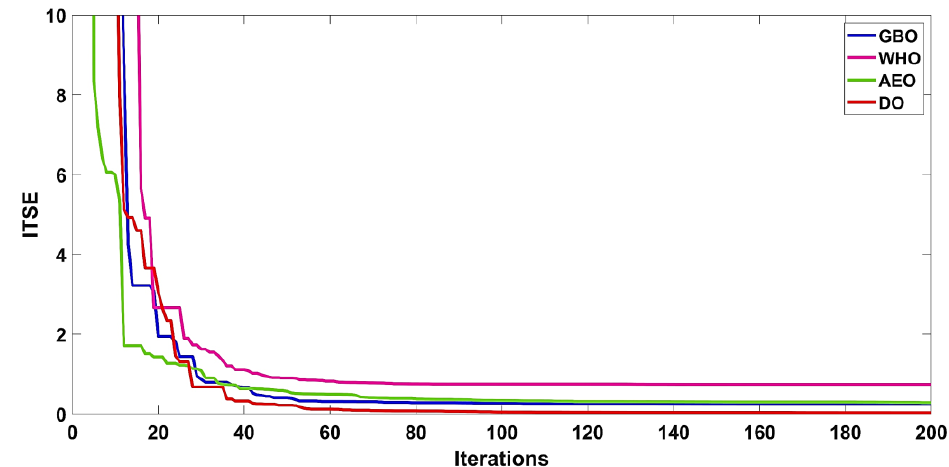
Figure 20. Convergence characteristics of all investigated algorithms.